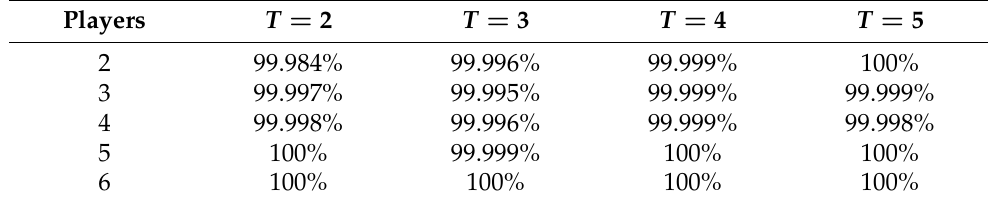
Table 11. Percentage of instances fulfilling the condition of Theorem 2 for instances with positive costs.